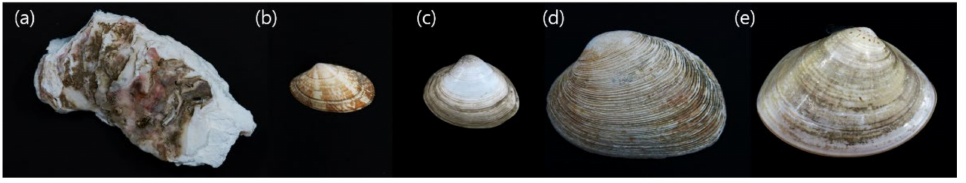
Figure 4. Shell samples for identification of materials by the experimental group: ( a ) CR-A ( b ) CR-B.